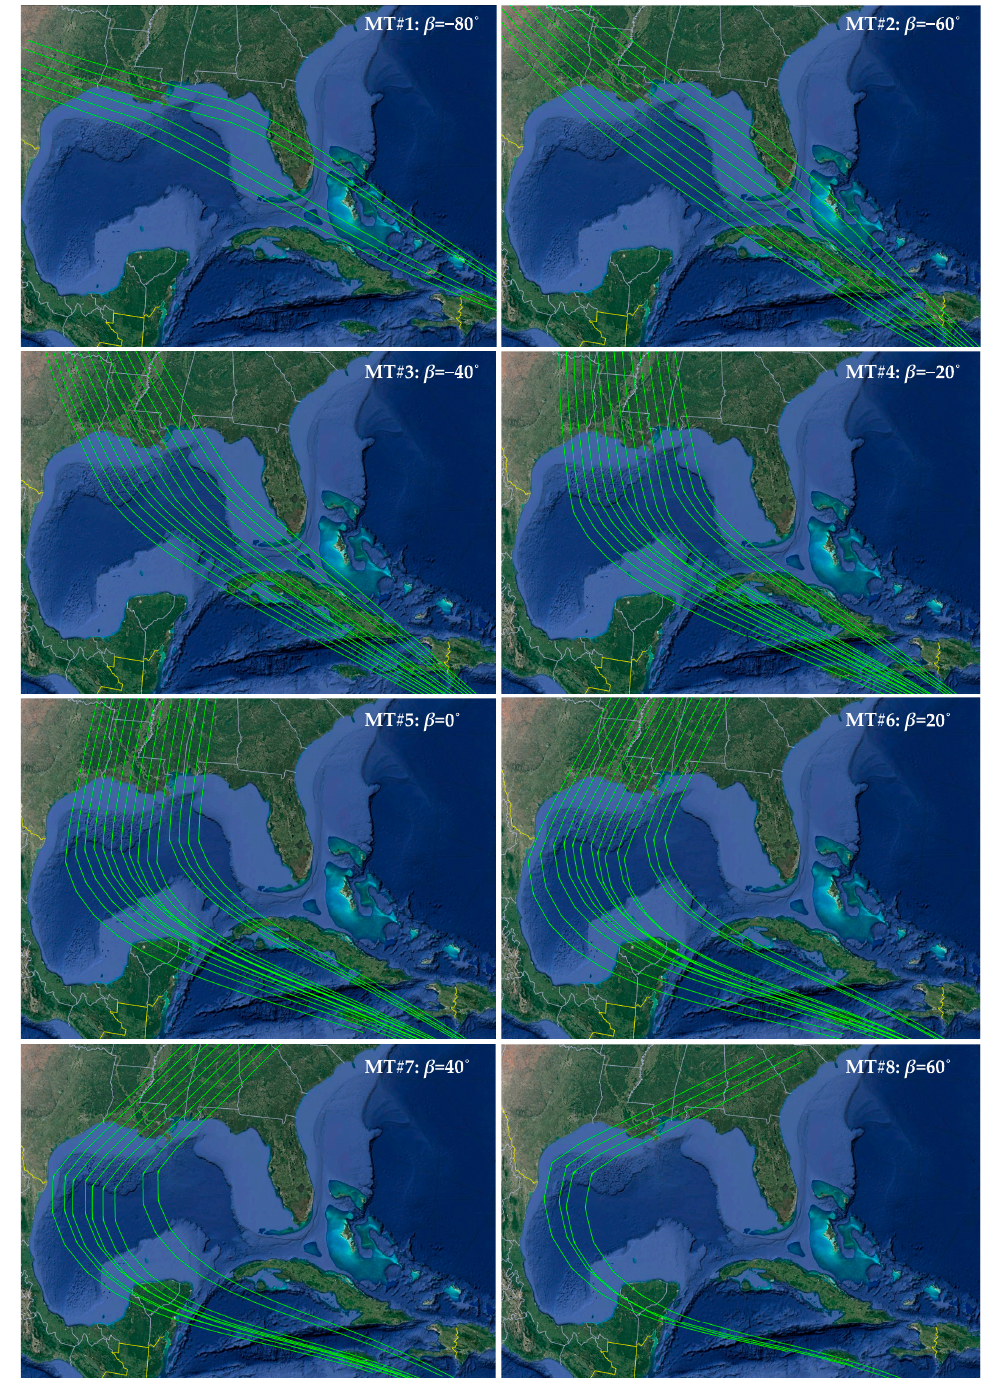
Figure 2. Storm tracks per master track (MT). Heading direction ( β ) per MT group also shown. A simplified, piece-wise linear coastal boundary is utilized for defining the reference landfall, also shown in Figure 1 (white solid line). The boundary simplification is chosen based on the recommendations in [14] to avoid any ambiguous definition of landfall due to the existence of bays. The input parameters x lat and x lon are defined when the synthetic storm track crosses this boundary.